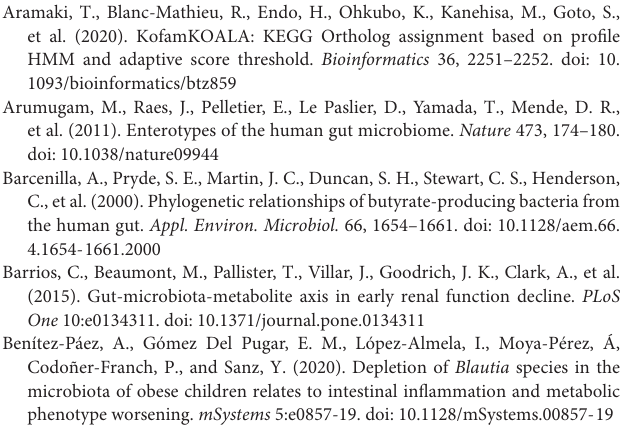
Supplementary Figure 6 | Heatmap of the completeness of KEGG modules in the core and shell genomes. Heatmap produced by MicrobeAnnotator (Ruiz-Perez